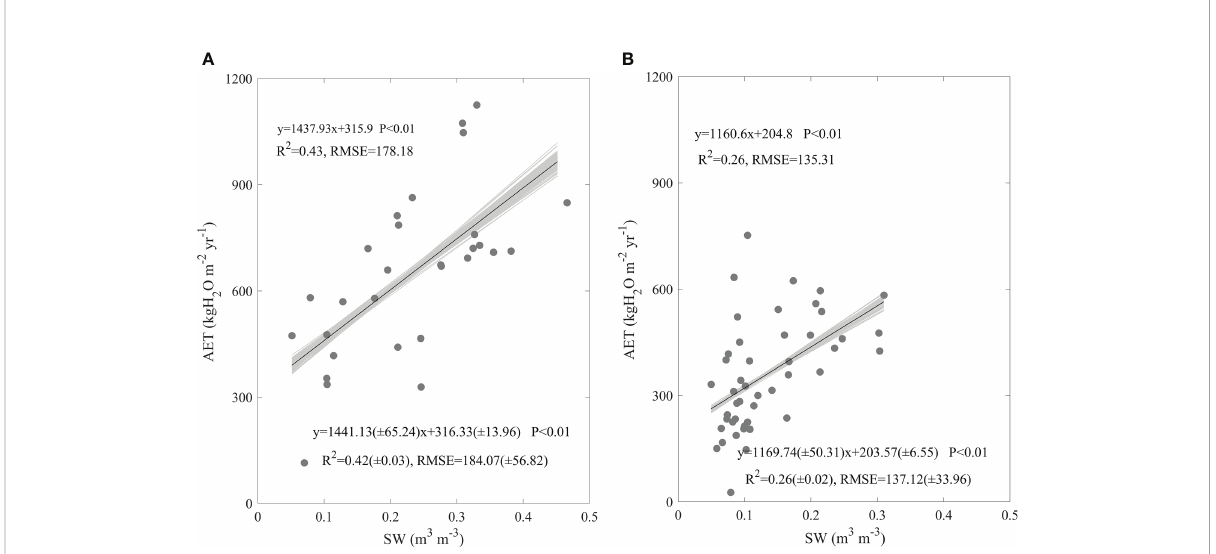
FIGURE 6 Effects of soil water content (SW) on the spatial variations of annual evapotranspiration (AET) in forests (A) and grasslands (B) in China. The grey lines are regression lines generated from the random error adding AET, whose statistics are presented in the right bottom of each panel.